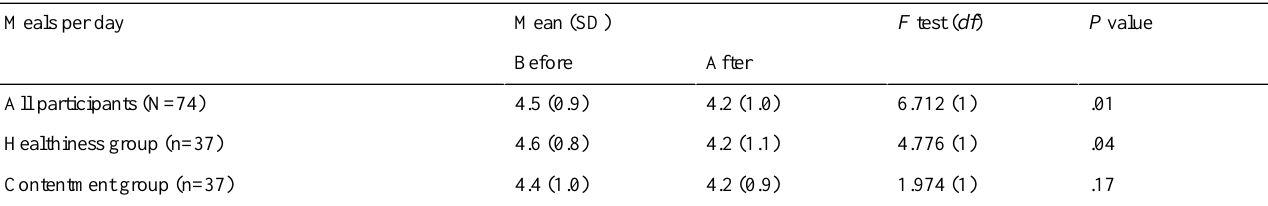
Table 3. The number of reported meals (breakfast, lunch, afternoon snack, dinner, evening snack, and other snacks) per day (mean [SD]) before and after the intervention in (1) all participants (N=74) and members of (2) Healthiness group (n=37), and (3) Contentment group (n=37).